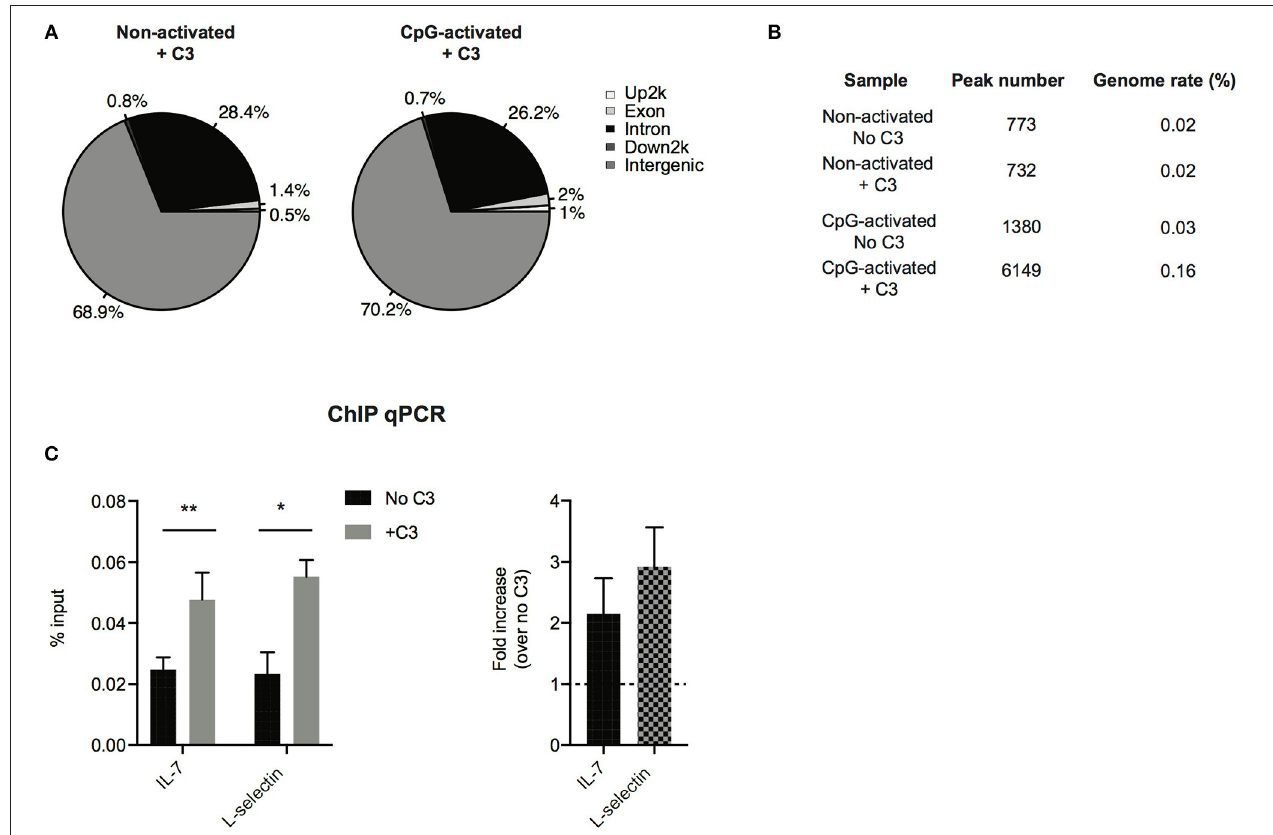
FIGURE 6 | Confirmation of C3-DNA interaction by ChIP sequencing. (A) ChIP-seq identified peaks from anti-C3 immunoprecipitated chromatin samples were classified based on the location (UCSC annotation data) and are shown in the following genome regions: intergenic, introns, downstream 5 Kbp, upstream 5 Kbp, and exons. The interacting DNA elements localized mainly the intergenic and intronic regions. (B) ChIP-seq statistics of identified peaks including peak numbers and genome rate (%). C3 binding to genomic DNA is strongly increased upon stimulation of B cells with the polyclonal activator, CpG oligonucleotide. (C) ChIP-PCR was run on ChIP DNA of CpG-activated samples using primers specific for the ChIP-seq identified regions in IL-7 and L-selectin genes. Enrichment of the specific DNA loci was calculated with the percent input method and illustrated as % input or as fold changes over samples without C3 treatment (two-way ANOVA with Sidak’s multiple comparison, * p < 0.05, ** p < 0.01). The values represent the mean ± SEM of four independent